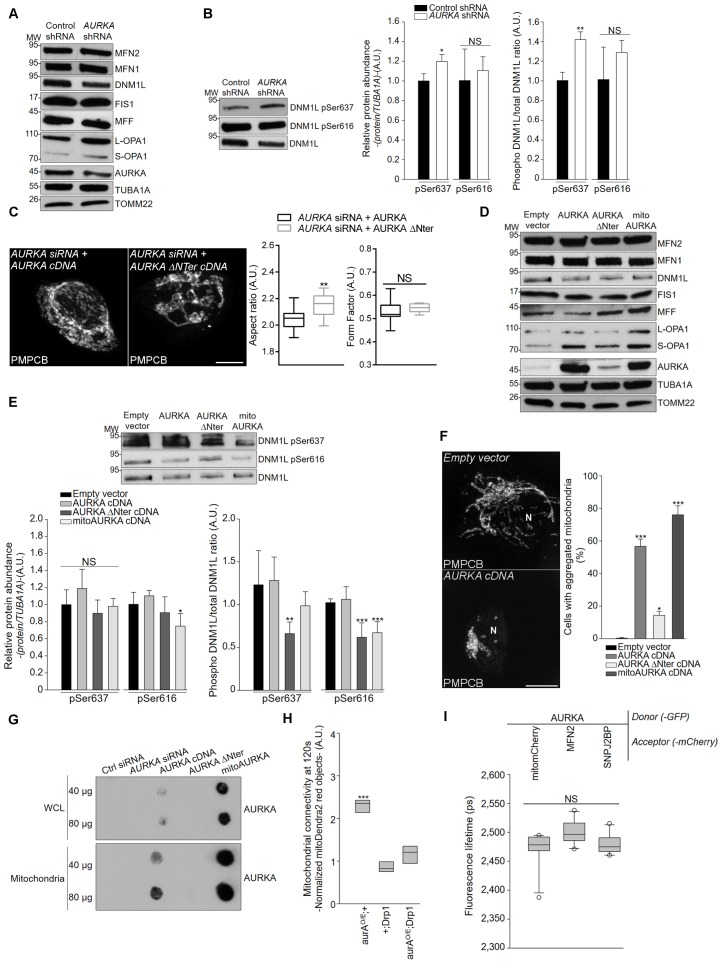
AURKA regulates mitochondrial fission when expressed at physiological levels while ectopic AURKA drives mitochondrial clustering and enhances mitochondrial fusion.(A) Total lysates of HEK293 cells transfected with control or AURKA-specific shRNAs and blotted for the indicated mitochondrial fusion and fission proteins. TOMM22: loading control. (B) Western blot of total lysates of HEK293 cells transfected as indicated and immunoblotted for total DNM1L or for phosphorylated Ser637 and Ser616 (pSer637 and pSer616 respectively) and quantification of the levels of total DNM1L, pSer637 DNM1L, and pSer616 DNM1L normalised to TUBA1A, and of the abundance of pSer637 DNM1L and pSer616 DNM1L each normalised to total DNM1L. n = 3 independent experiments. (C) Representative micrograph (left) and quantification (right) of the length and the branching of the mitochondrial network in MCF7 cells transfected with an AURKA-specific siRNA and expressing normal or ΔNter AURKA under the endogenous AURKA promoter. n = 30 images per condition obtained from three independent experiments. Scale bar: 10 µm. (D) Total lysates of HEK293 cells transfected with an empty vector, AURKA or the indicated variants all fused to a 6xHis tag and blotted for the indicated mitochondrial fusion and fission proteins. TOMM22: loading control. (E) Representative blot and corresponding quantification of the levels of total DNM1L, pSer637 DNM1L, and pSer616 DNM1L normalised to TUBA1A, and of the abundance of pSer637 DNM1L and pSer616 DNM1L each normalised to total DNM1L in cells transfected as in (D). n = 3 independent experiments. (F) Representative micrograph (left) and quantification (right) of mitochondrial clusters observed in MCF7 cells under the indicated transfection conditions. N: nucleus. n = 30 images per condition obtained from three independent experiments. Scale bar: 10 µm. (G) Representative dot-blot filter retardation assays of whole cell lysates (WCL) and mitochondrial fractions from HEK293 cells transfected with 6xHis AURKA-cDNA, AURKAΔNter or mitoAURKA. Only SDS-insoluble aggregates are retained on the membrane. Forty or 80 µg of protein was loaded (as indicated) and immunoblotted for AURKA. (H) Analysis of the number of red mitochondria at 120 s after photoconversion normalised against the quantity of mitochondria in the ROI 5 s after photoconversion in Drosophila pupae over-expressing AurA with or without over-expressing Drp1. n = 80 images per condition from eight independent pupae obtained from three independent crossings. (I) GFP lifetime quantifications of the indicated donor-acceptor pairs in mitochondria. n = 10 images from one representative experiment (of three). Data represent means ±s.e.m; boxplot data range from the 10th to the 90th percentile. *p<0.05, **p<0.01, ***p<0.001 compared to the corresponding ‘Control shRNA’ condition (B), to the ‘AURKA siRNA + AURKA’ condition (C), to the ‘Empty vector’ condition (E, F), or to the aurAO/E; +’ condition (H). NS: not significant.